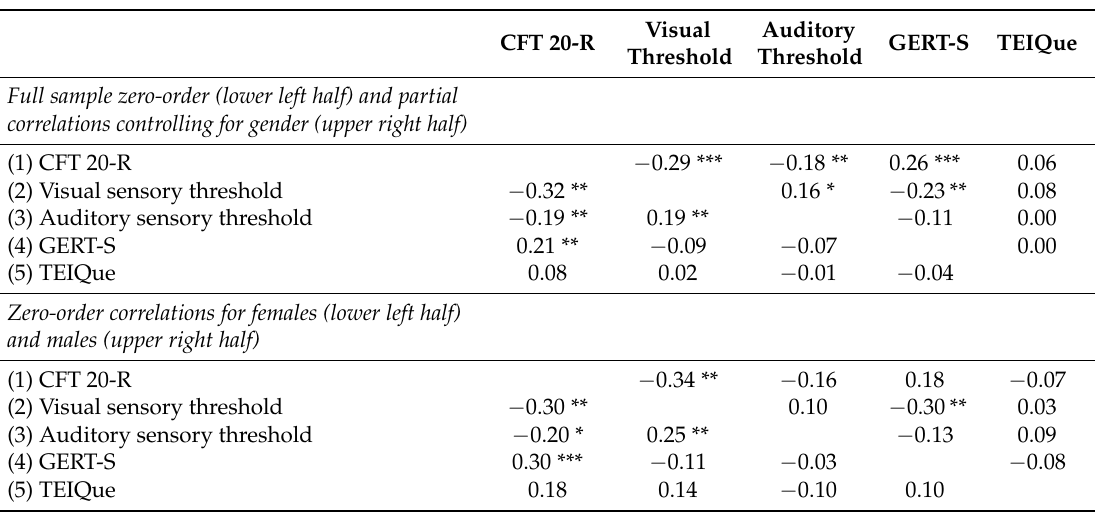
Table 2. Zero-order correlations and partial correlations (Spearman’s rho) between emotion recognition, psychometric intelligence, and trait emotional intelligence measures for the full sample ( n = 214), and separately for males ( n = 106) and females ( n =